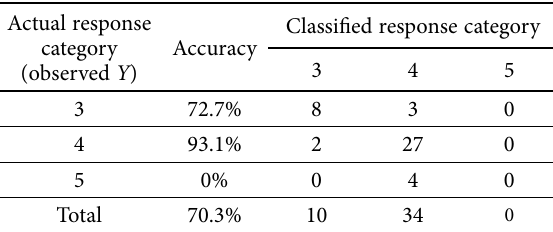
Table 4. Accuracy of the classification for response categories based on the regression model in logit link with 2 factors Actual response